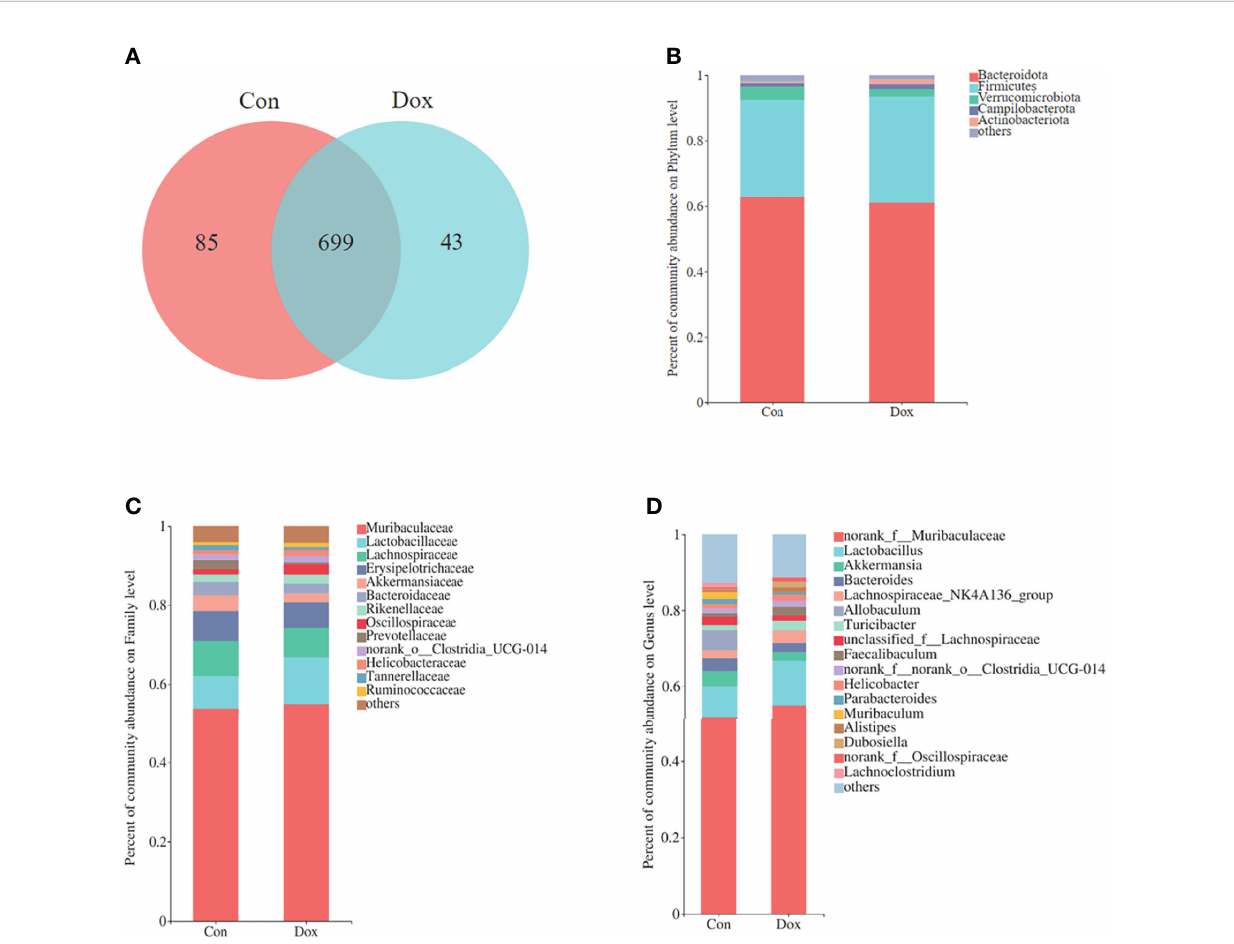
FIGURE 2 | Comparison of the microbial composition between the two groups. (A) Venn diagram depicting OTU richness and the overlap representing the shared OTUs in microbial communities. (B – D) Relative abundance of microbial community for each group at phylum, family, and genus levels. Con, control; Dox, doxorubicin; OTU, operational taxonomic unit. n =